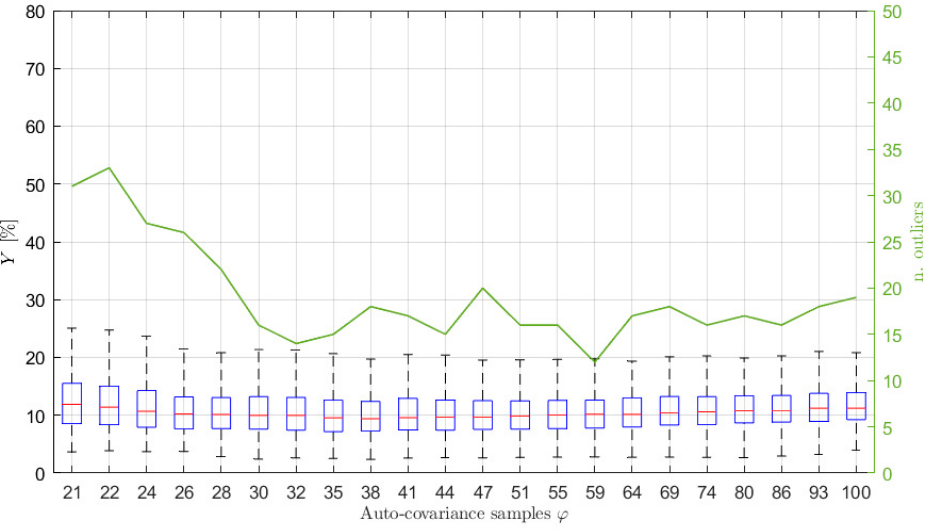
Figure 3. Box plot (left vertical axis) and number of outliers (solid line and right vertical axis) as functions of the number φ of auto − covariance samples used to write Equation (14) for 𝑝̂ = 10, 𝑥 3600s long and sampled at 1 Hz. The typical values of φ(cid:3549) are between 34 and 36.